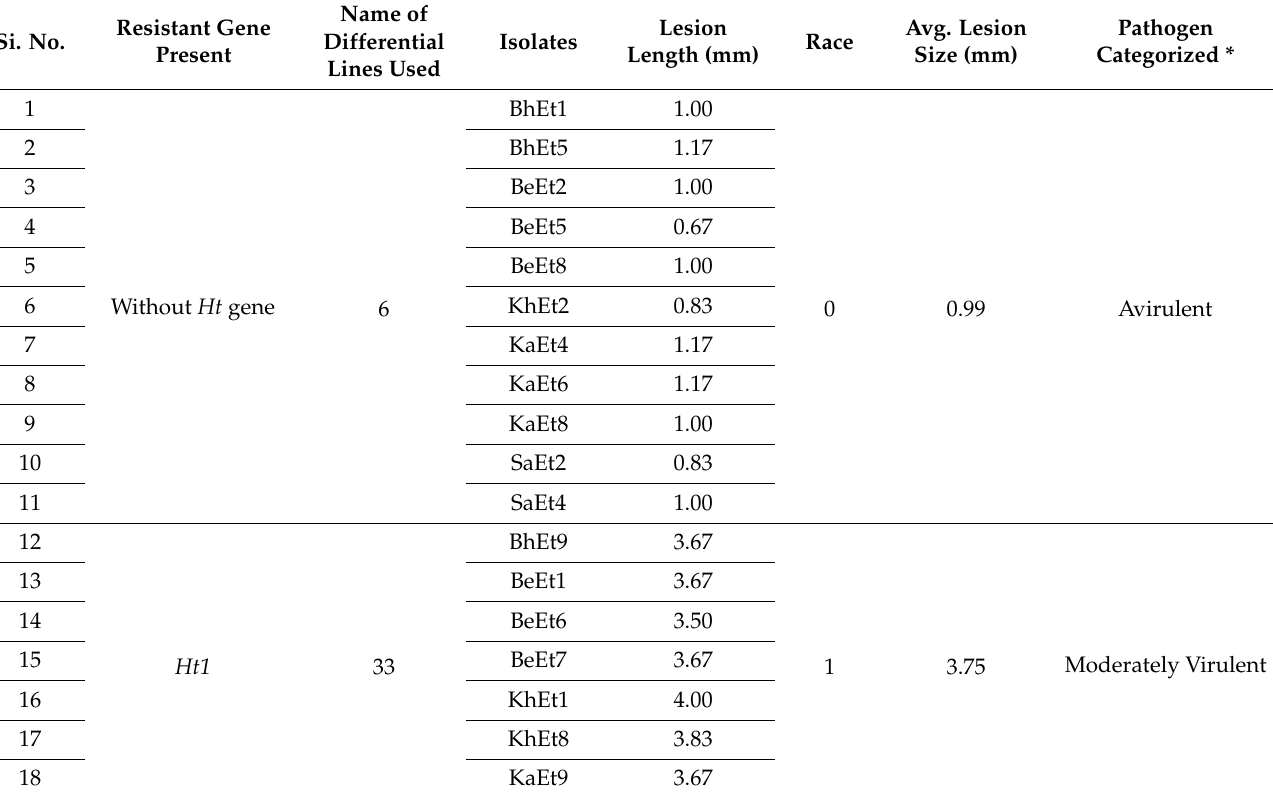
Table 2. Race determination based on differential lines and lesion length (mm) of E. turcicum isolates.